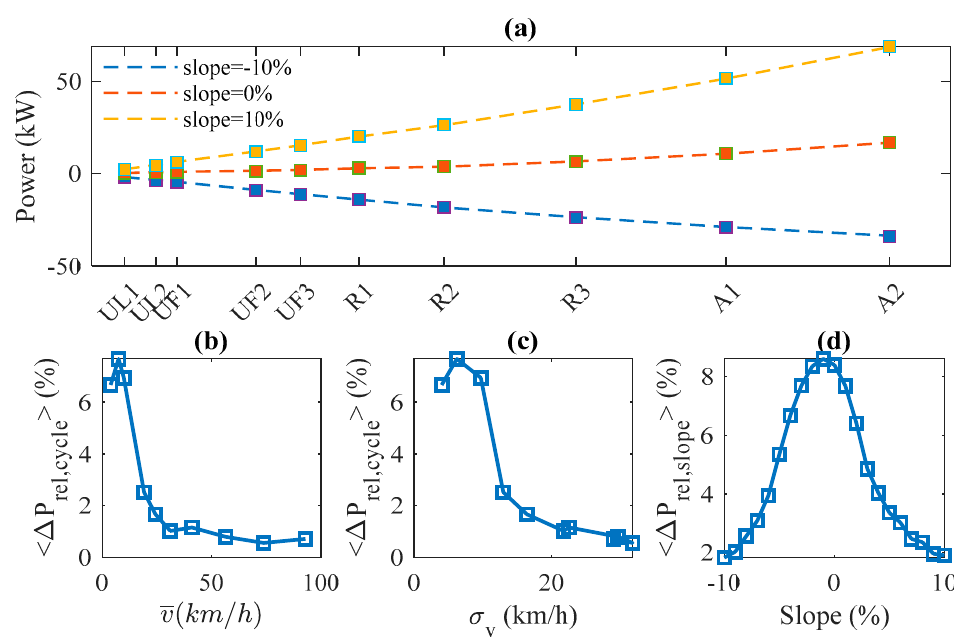
Figure 8. Power estimator assessment for the 10 INRETS driving cycles: ( a ) (cid:1842) (cid:3047)(cid:3045)(cid:3028)(cid:3030)(cid:3047)(cid:3114)(cid:3042)(cid:3041) (cid:3364)(cid:3364)(cid:3364)(cid:3364)(cid:3364)(cid:3364)(cid:3364)(cid:3364)(cid:3364)(cid:3364)(cid:3364) (squares) and